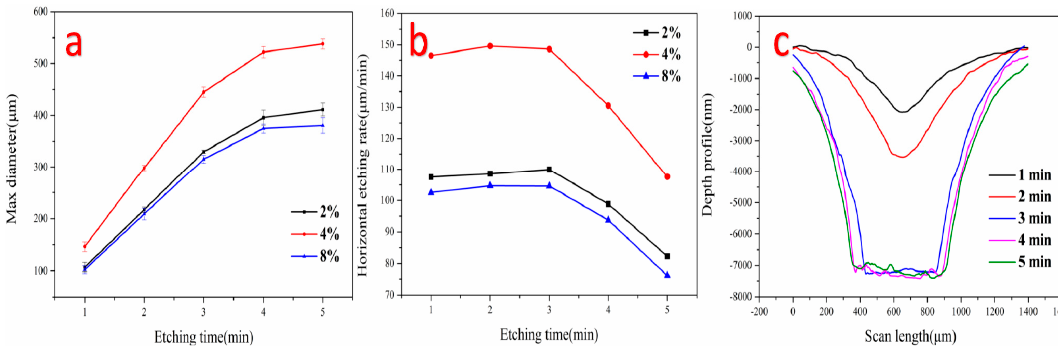
Figure 8. ( a ) The maximum diameter of the microholes on the polymer at the different distance between nozzle and substrate; ( b ) time-dependent maximum diameter of the microholes at different additive oxygen ratios; ( c ) depth profiles of microholes etched by plasma microjets. Experimental conditions: 700 sccm helium gas and 28 sccm additive oxygen at an applied voltage of 8.5 kV pp , the frequency was around 11 kHz.